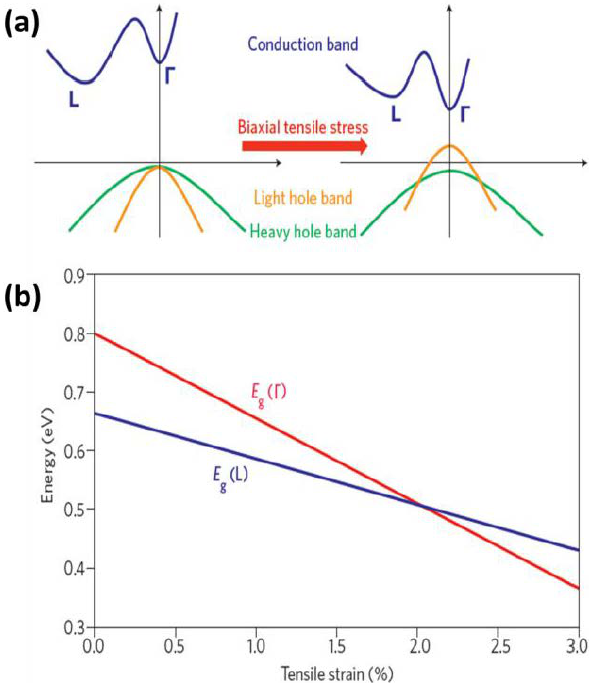
Figure 3: The effect of tensile strain on the band structure of Ge. (a) Schematic of how the band diagram changes as biaxial tensile strain is applied. (b) Plot of the band gap energies for the Γ and L bands as a function of tensile strain. Figure with reprint permission from Ref. [62] ©2010 Nature publishing